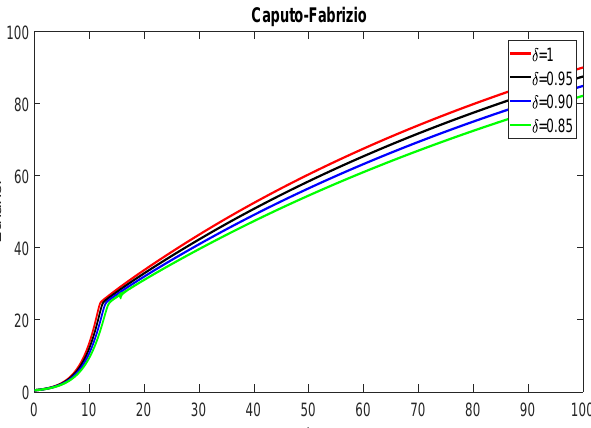
Figure 4. Evolution of the substrate, biomass, and ethanol for fractal dimension 0.9 and different fractional orders in Caputo–Fabrizio sense.